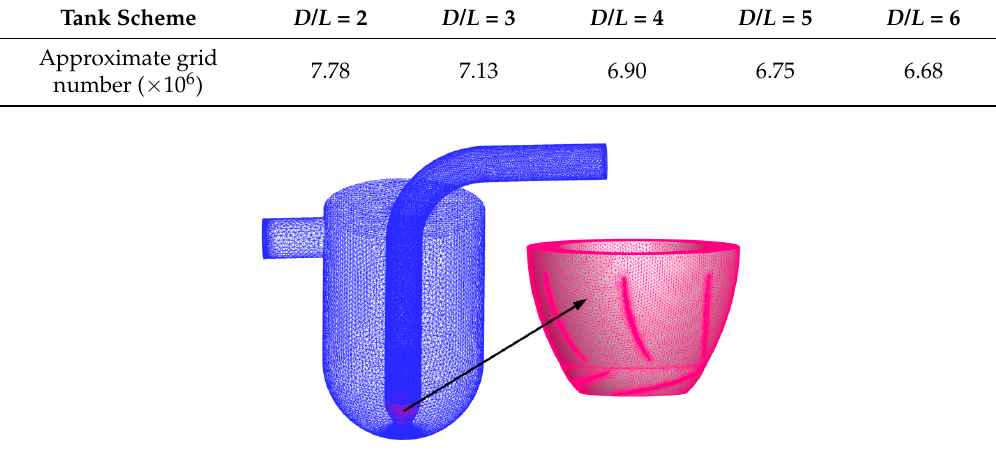
Figure 4. Grids for the computation domain of the scheme of D / L = 2.